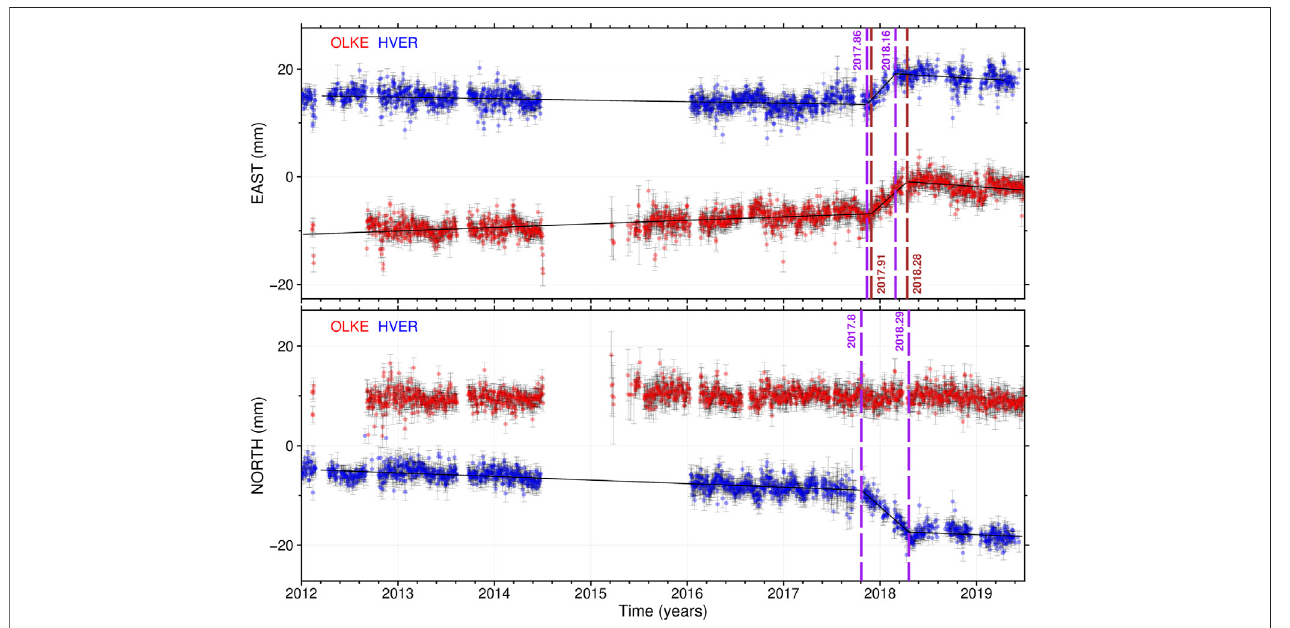
FIGURE6| Estimationoftheupliftsignal(2017 – 2018). Thered andbluedotsshowthedetrendeddatasetsoftheÖlkelduháls (OLKE,red)andHveragerði(HVER, blue)cGNSStimeseriesineast,northcomponents.Theblacklinesshowthebest fi tofourweightedoptimisationprocessusedtodeterminetheuplifttimespanforeach component and both stations. The estimated start and end of the uplift in each estimated components are shown with dashed lines in purple and brown for the HVER and OLKE stations, respectively.